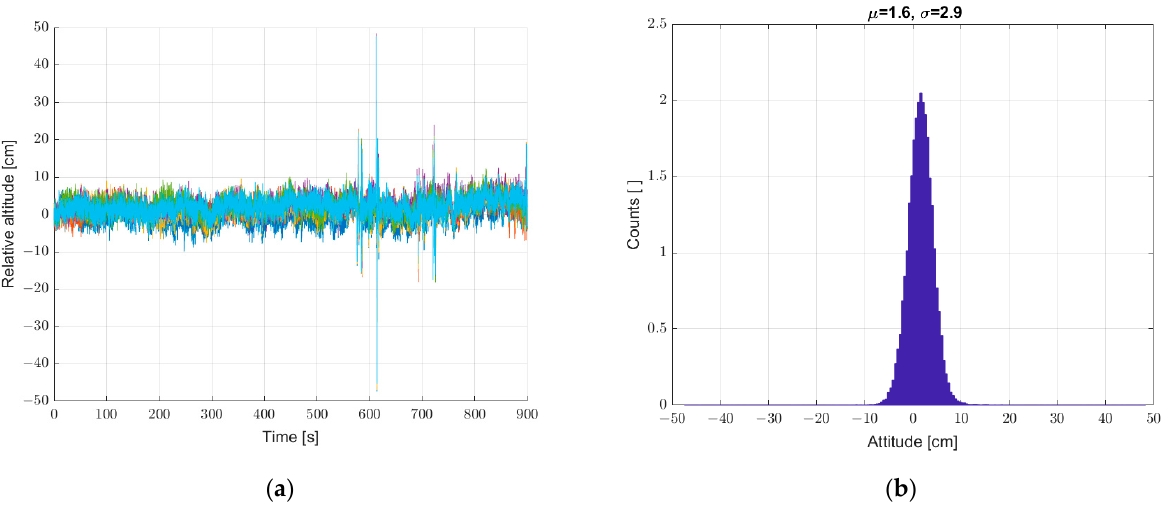
Figure 7. ( a ) Graph over time from six sensors with correction from reference sensor, and ( b ) histogram. Static measurements—sensor array at standstill.